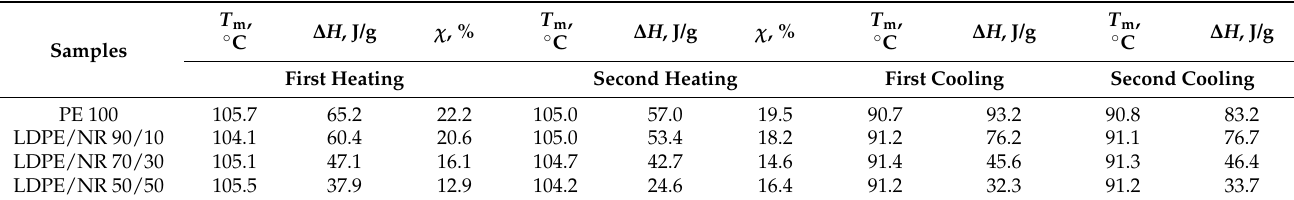
Table 5. Differential scanning calorimetry of the initial samples.